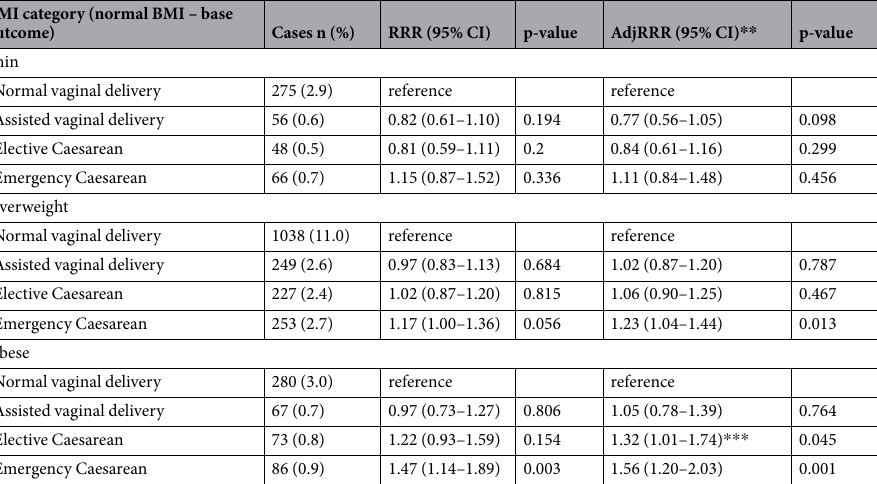
Table 3. Mode of delivery and body mass index at age three years. N for adjusted model = 9466. Multinomial logistic regression. BMI – Body mass index, RRR (Relative Risk Ratio), CI (Confidence intervals), Adj